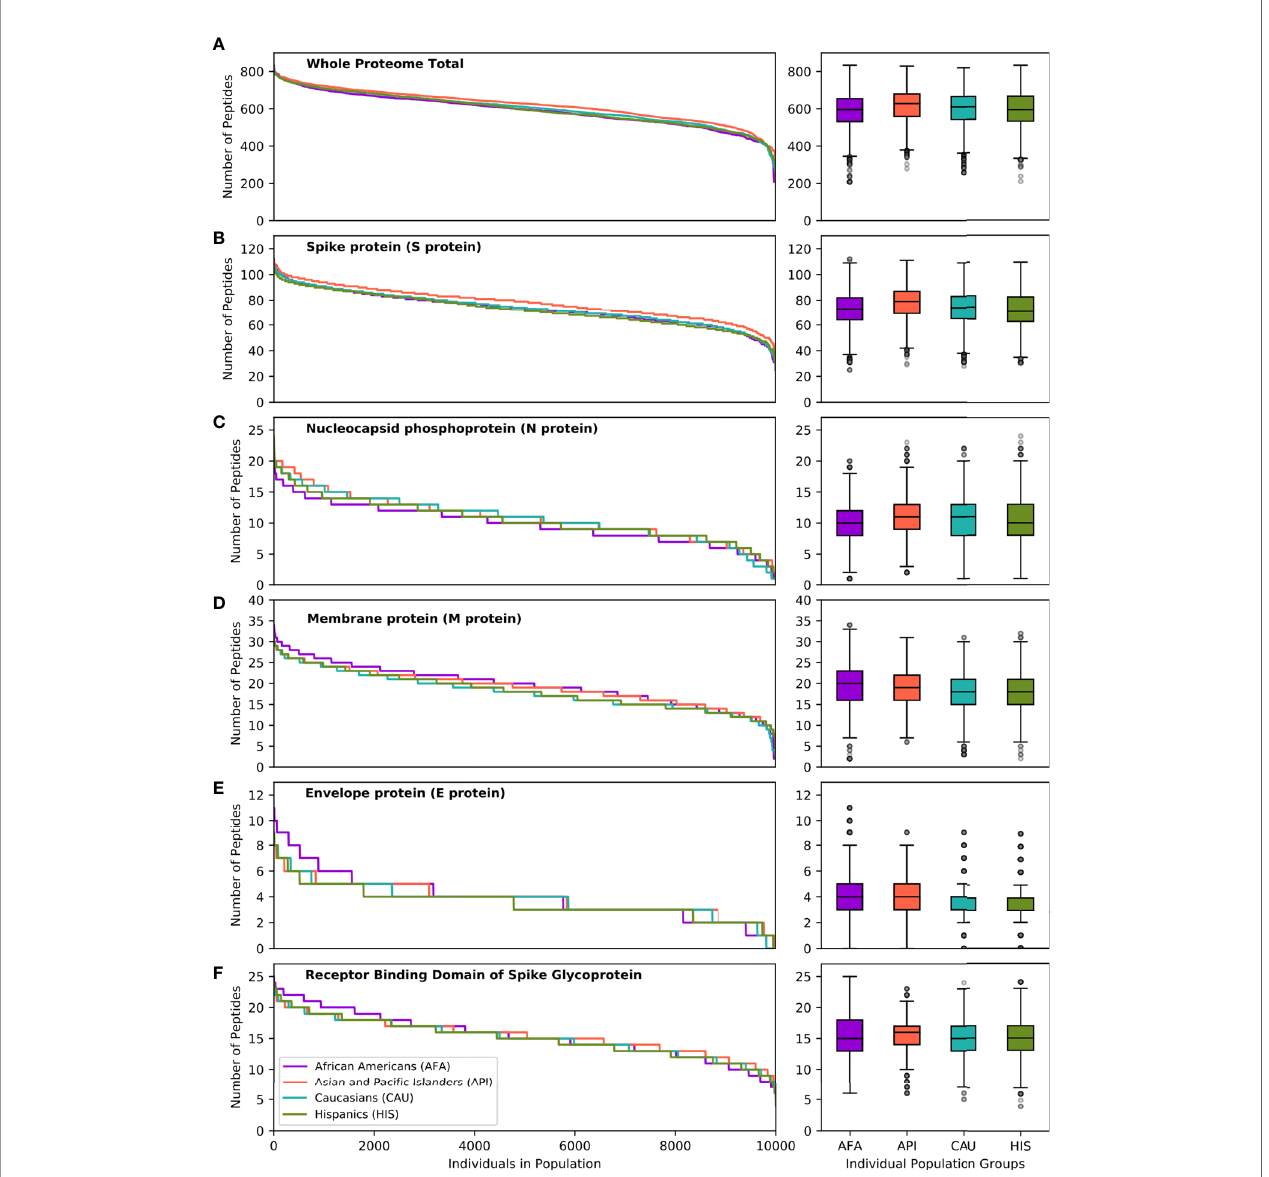
FIGURE 3 | SARS-CoV-2 derived peptide presentation at the HLA genotype level (broad population groups). Panels depict the number of SARS-CoV-2 peptides presented by individual HLA class II genotypes in simulated populations of 10,000 individuals for four broad population groups (African Americans, Asian Paci fi c Islanders, Caucasians and Hispanics). (A) Whole Proteome. (B) Spike protein (S protein). (C) . Nucleocapsid protein (N protein). (D) Membrane protein (M protein). (E) Envelope protein (E protein). (F) Receptor Binding Domain of Spike protein. The width of each step in the curves is proportional to the relative frequency of a speci fi c HLA genotype. The boxplot charts depict the median, interquartile range (box) and range (whiskers - excluding outliers) for the number of viral peptides presented at the population level for each of the above ethnic